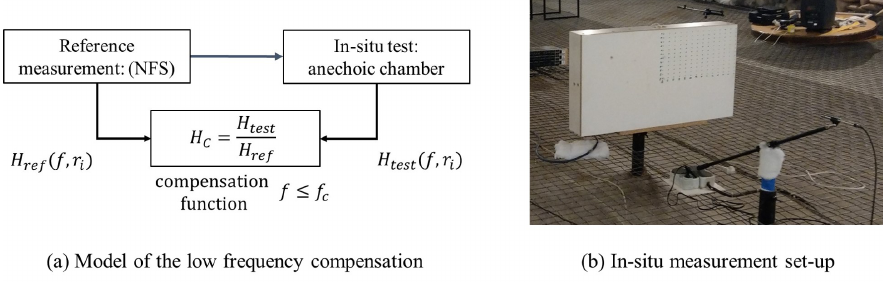
Figure 4. ( a ) Generating the compensation function based on a reference measurement with Klippel near field scanner (NFS); and ( b ) an in situ test for low-frequency measurements in the test environment.